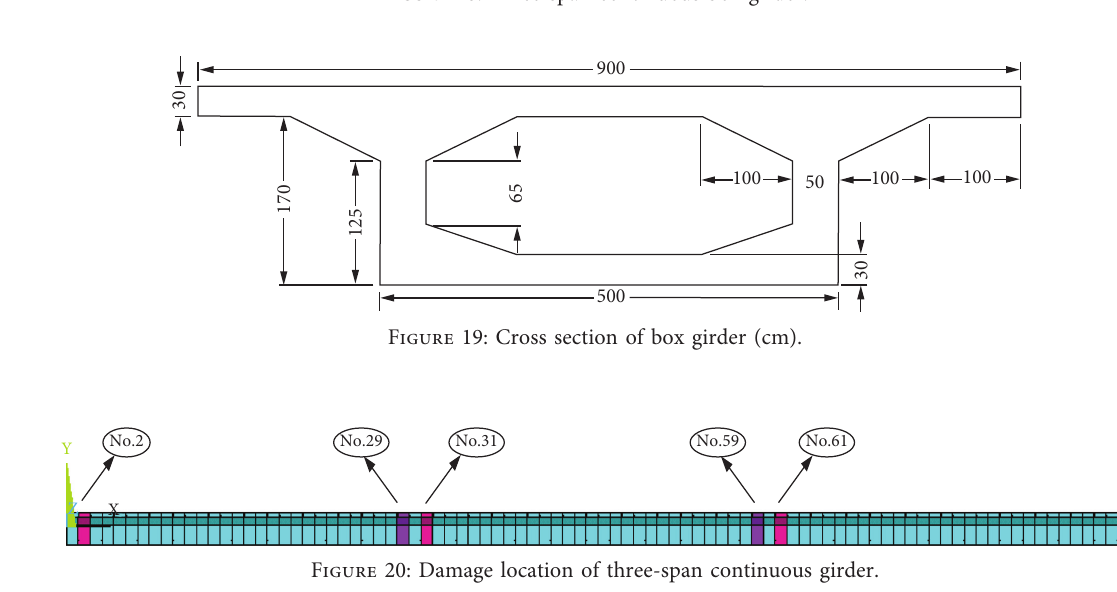
Figure 18: Three-span continuous box girder.